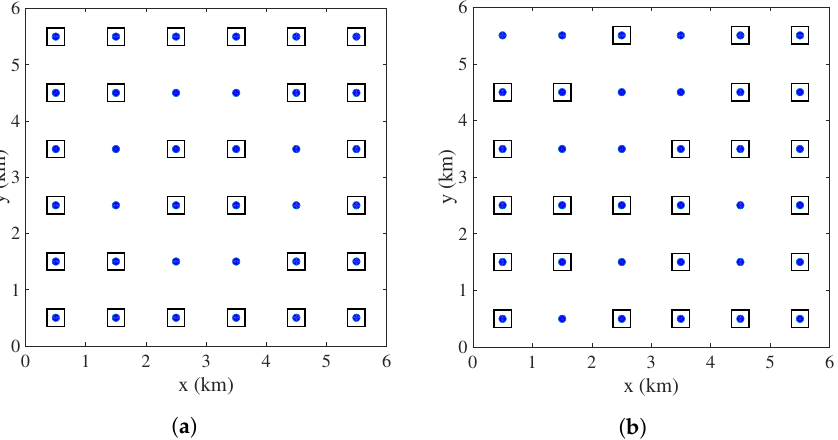
Figure 10. ( a ) Sensor placement pattern for the Σ s as shown in Figure 9a; ( b ) Sensor placement pattern for the Σ s as shown in Figure